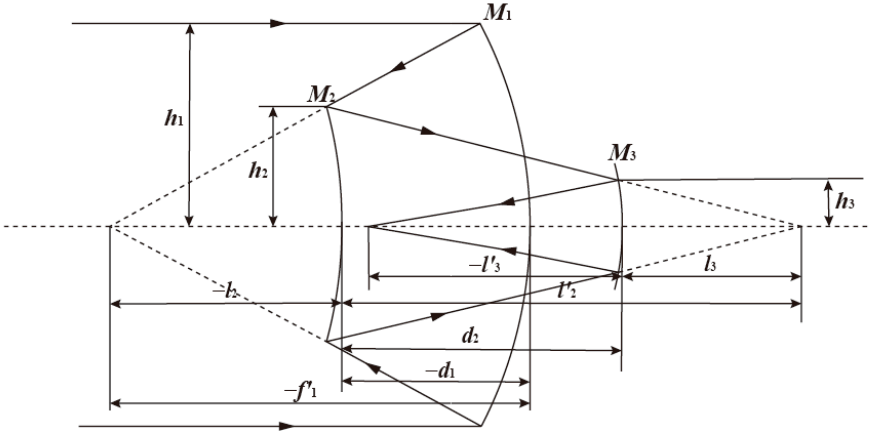
Figure 10. The schematic diagram of the initial coaxial reflective optical system structure.